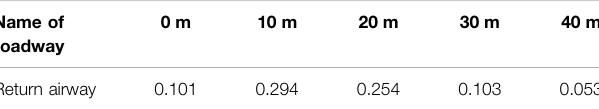
and Figure 15 respectively. The statistical table of attenuation rate of overpressure peak in working face every 20 m and the variation law of attenuation rate are shown in Table 5 and Figure 16 , respectively. The statistical table of attenuation rate per 10 m of peak overpressure in the return airway and the variation curve of attenuation rate are shown in Table 6 and Figure 17 respectively.